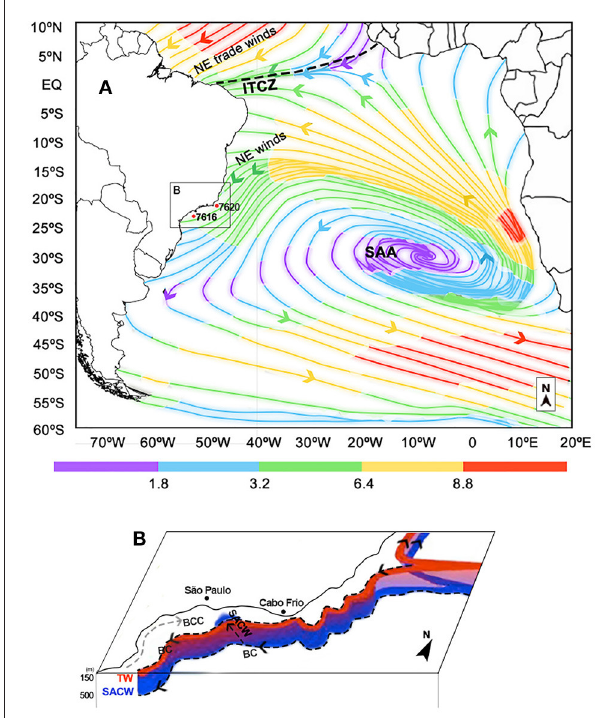
FIGURE 2 | (A) Wind field average in 1,000 hPa, for summer months (DJF) obtaining from daily National Centers for Environmental Prediction (NCEP) data during a period from 1978 to 1997: colored lines representing wind current speed (m/s), modified after Bastos and Ferreira (2008). (B) Zoom of currents and water masses prevailing in the study area, showing the displacement of the South Atlantic Coastal Water (SACW) and the Tropical Water (TW) transport by Brazil Current (BC); water masses are simplified from Calado